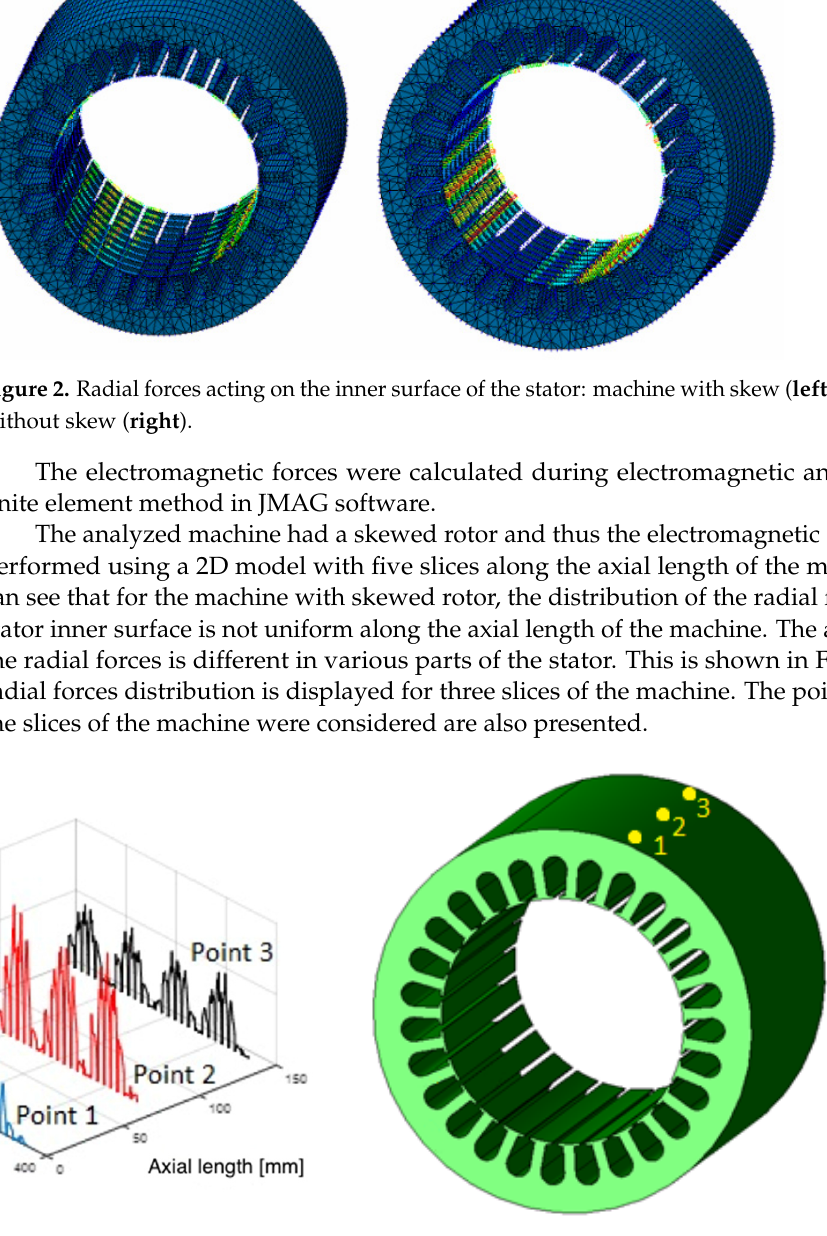
Figure 3. Radial forces acting on the stator with skewed rotor ( left ), points on the stator where the radial forces were measured ( right ).